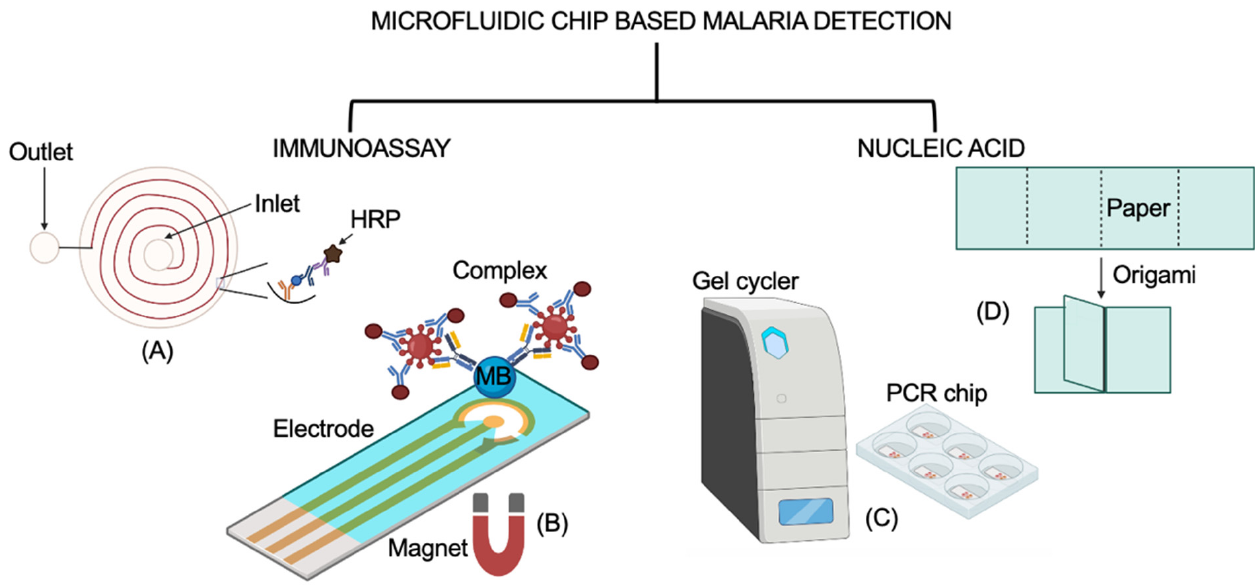
Figure 6. A schematic representation of two types of microfluidic chip biosensors for the detection of malaria disease. ( A , B ) are categorized as immunoassay-based microfluidic chip biosensors, while ( C , D ) are nucleic acid microfluidic chip biosensors. ( A ) Spiral microfluidic channel for immunoassay. Adapted from ref. [83]. ( B ) Paper-based single-step magneto-immunoassay. Adapted from ref. [84]. ( C ) PCR lab-on-chip with portable gel cycler. Adapted from ref. [8]. ( D ) Three-dimensional micropad origami-folded device for nucleic acid-based assay. Adapted from ref. [85]. The representation of